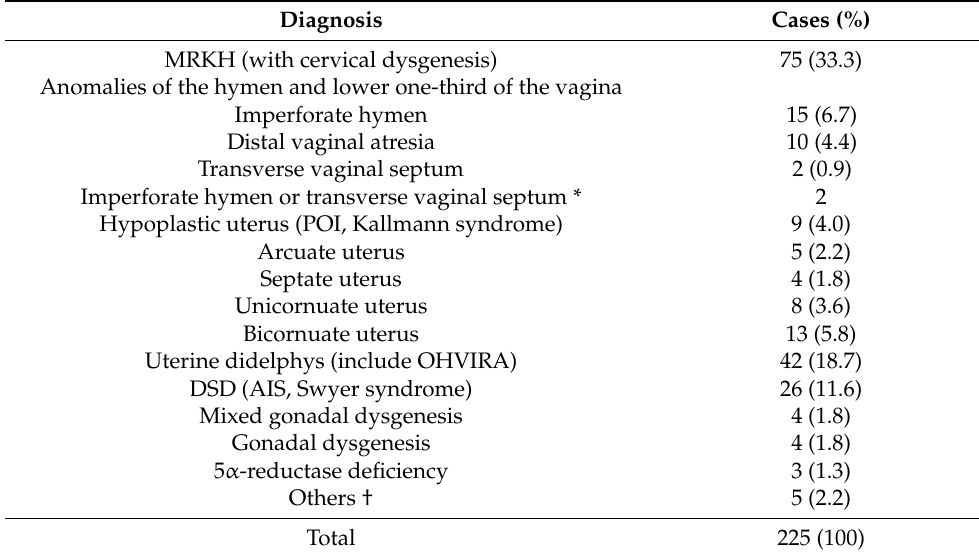
Table 1. The diagnosis of pelvic magnetic resonance imaging in 225 patients with genital tract anomalies. Diagnosis Cases (%) MRKH (with cervical dysgenesis) 75